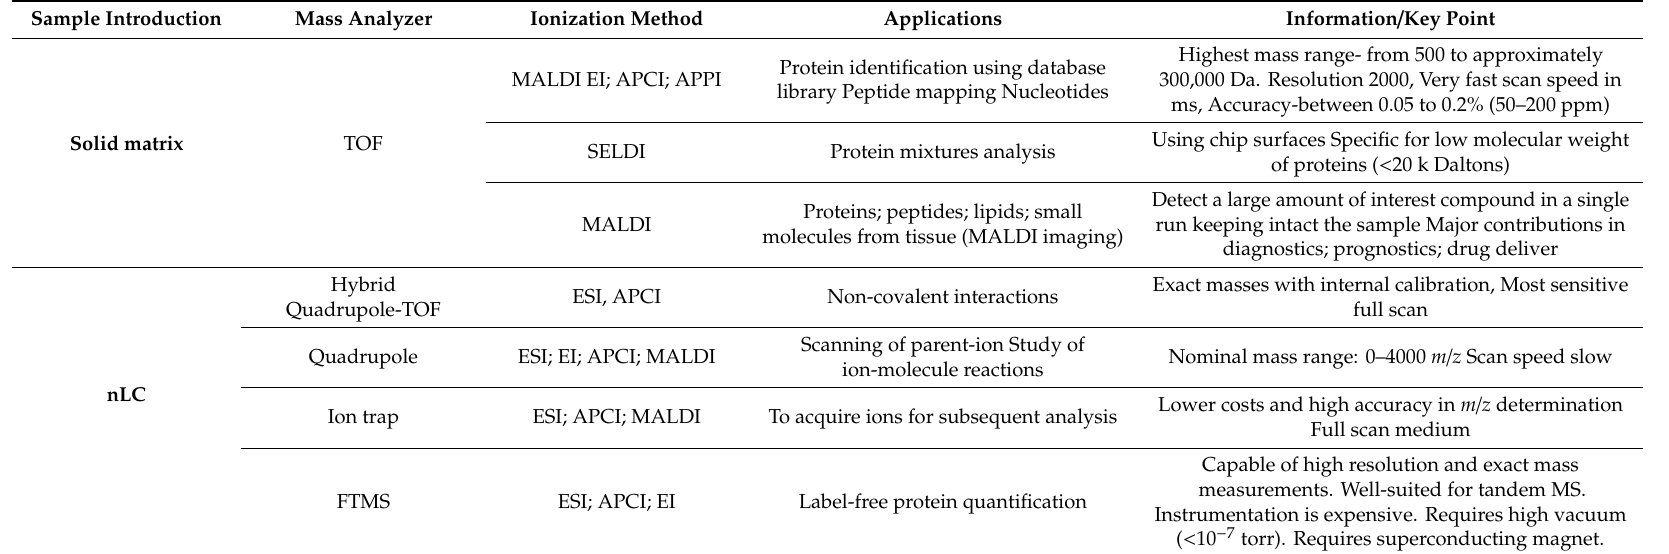
Table A1. Mass spectrometry analyses used in personalized